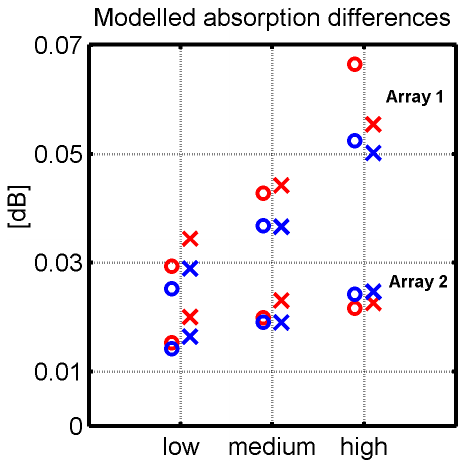
Fig. 4. Spatially integrated absorption differences for all combina- tions of antenna fields (Array 1 and Array 2), modes ( x and o ), sea- son (red=summer, blue=winter) and electron density (low, medium, high); in total 24 cases.